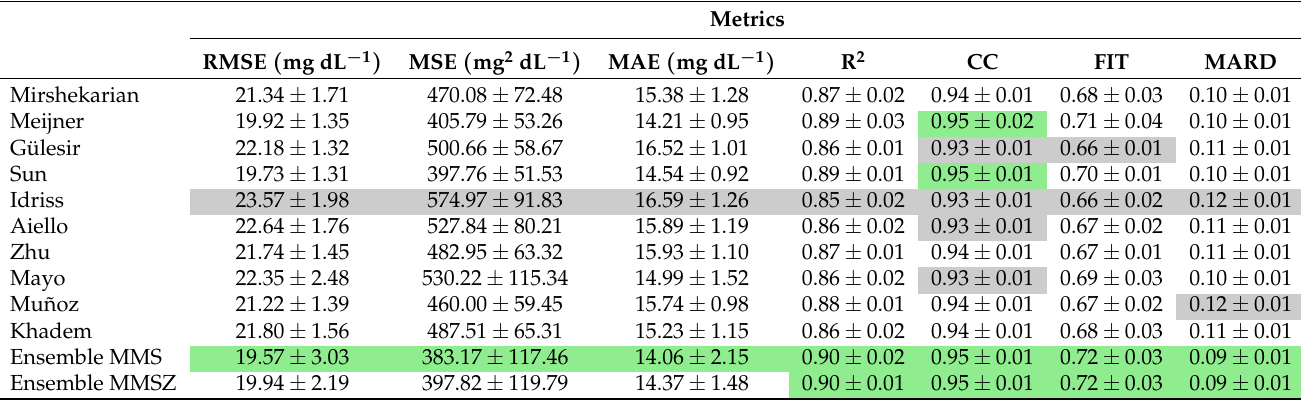
Table 11. Results of the ten NN models for each performance metric for ph = 30min. Green cells in each column highlight the model with the best performance, whereas the grey-colored cells are the worst.